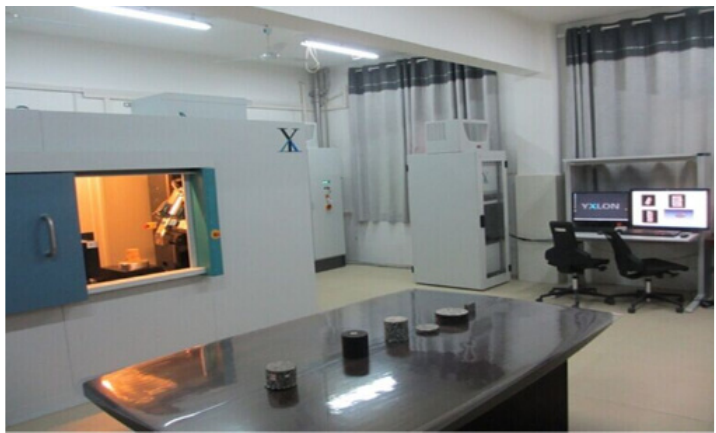
Figure 2. The X-ray CT scanning room.